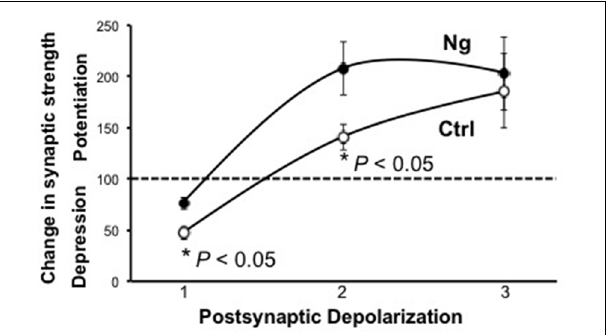
FIGURE 2 | Ng regulates metaplasticity at CA1 hippocampal synapses. The graph represents experimental data from control and Ng-expressing neurons from organotypic hippocampal slices. All three protocols used were pairing protocols where presynaptic stimulation is paired with postsynaptic depolarization. Protocol #1:1 Hz stimulation (500 pulses) paired with − 40 mV depolarization. Protocol #2:3 Hz stimulation (300 pulses) paired with − 20 mV depolarization (Zhong and Gerges, 2012). The time-course of this experiment has been shown previously (Zhong and Gerges, 2012) Protocol #3:3 Hz stimulation (300 pulses) paired with 0 mV postsynaptic depolarization (Zhong et al., 2009). The time-course of this experiment has been shown previously (Zhong et al.,